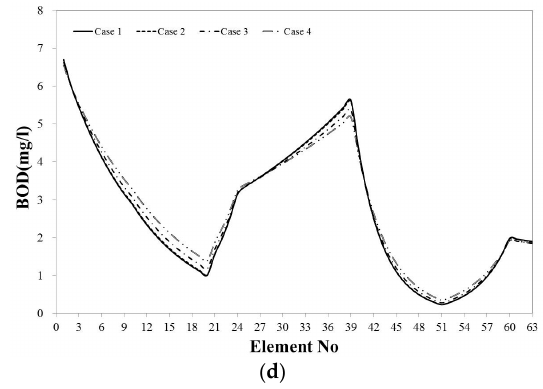
Figure 11. Results of BOD analysis for each case (April 2008): ( a ) Daecheong Dam to Sejong Weir; ( b ) Sejong Weir to Gongju Weir; ( c ) Gongju Weir to Baekje Weir; and ( d ) Baekje Weir to Estuary.